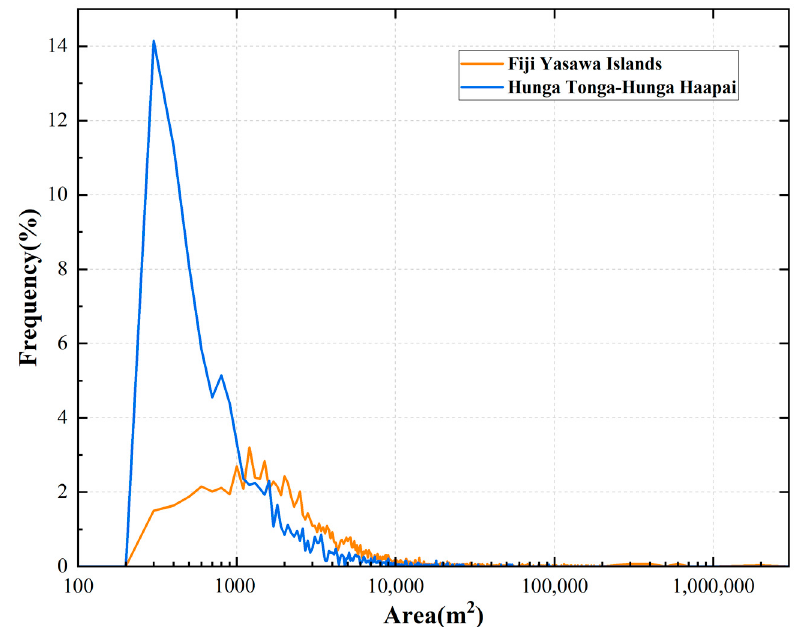
Figure 10. The frequency of area for all extracted pumice rafts.